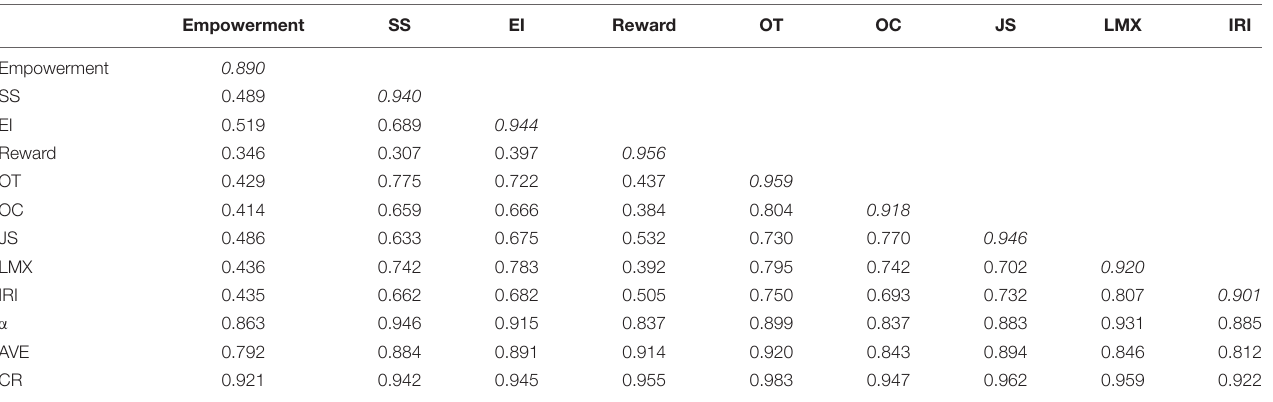
TABLE 1 | Measurement. Empowerment